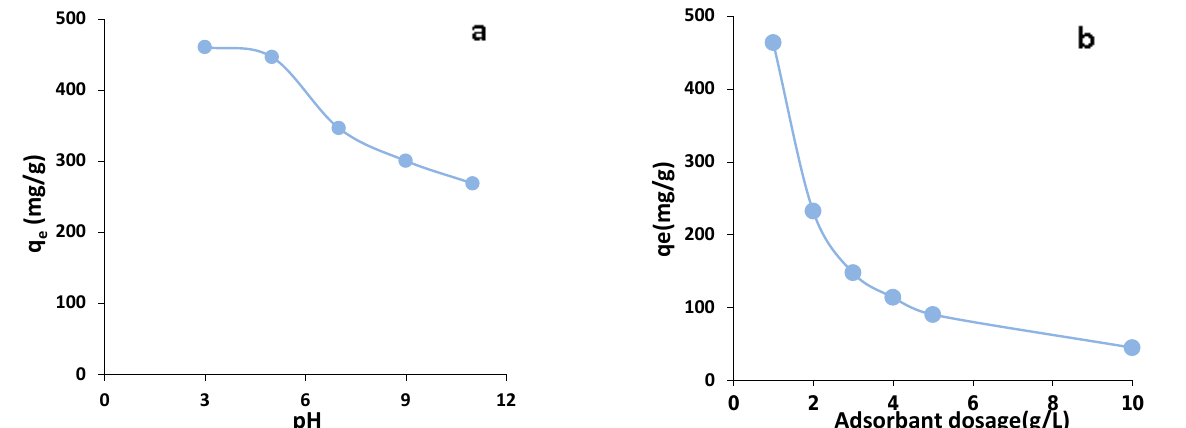
Figure 4. (a) The effect of pH on sorption (contact time = 20 minutes, BCG concentration = 500 mg/l, adsorbent dosage = 1 g/l) and (b) the effect of adsorbent dosage on sorption (contact time = 20 minutes, Bromocresol green (BCG) concentration = 500 mg/l, and solution pH =